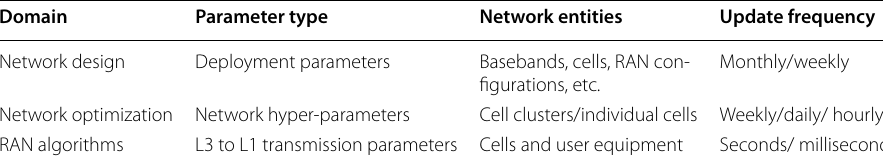
Table 2 Three domains for RAN performance improvement [84]